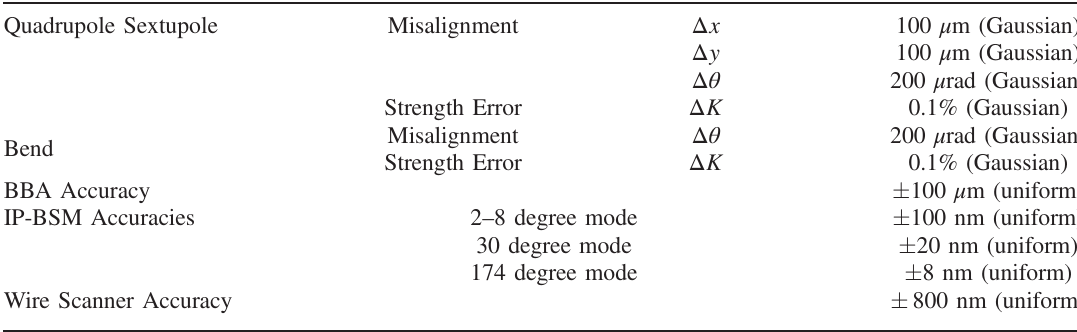
TABLE II. Error distributions for the beam tuning